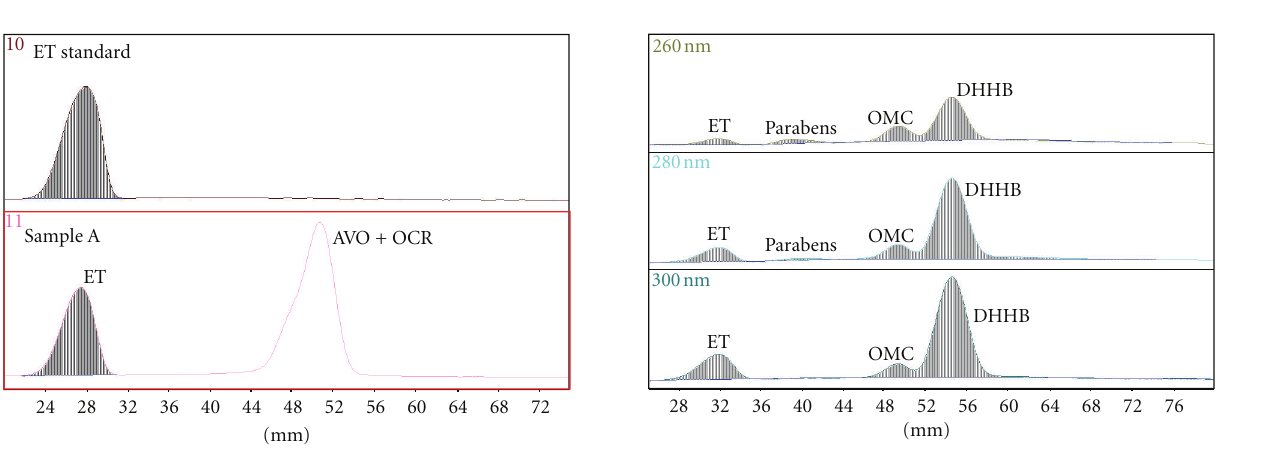
Figure 4: Multiwavelength scans of Sample B (260–300 nm), cyclohexane-diethyl ether-isopropanol 15:1: 1 (v/v/v).